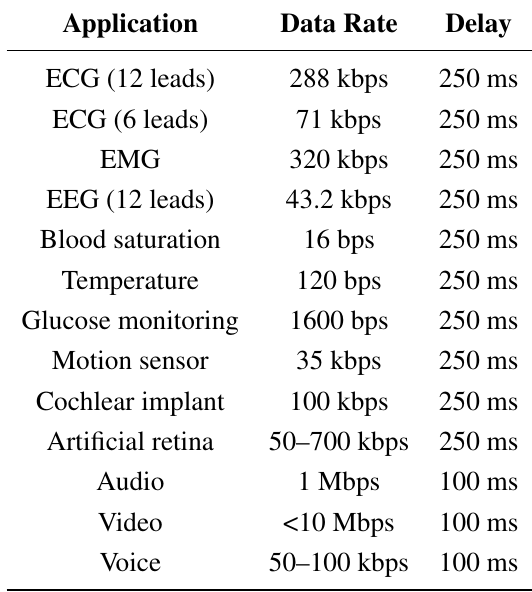
Table 1. Data rates and delay demands of WBAN applications.